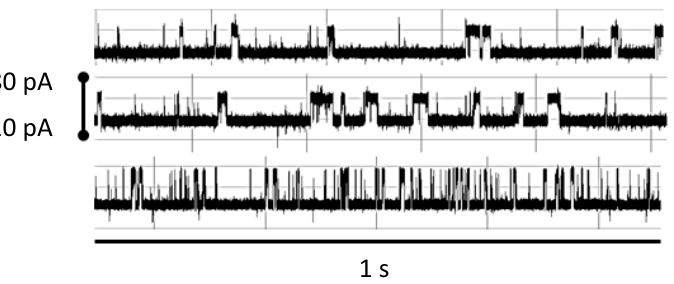
Figure 9. Robust NTD mAb-Bt-8gc (the mAb has biotin as antigen) binding signal under 100-fold biotin excess shows minimal interference effect (signals top middle show before after), while introduction of small amounts of chaotrope (<1 M urea) change the blockade signal significantly (bottom signal). Each signal is shown in a pA range from 20 to 80. The window of observation time is 1 s.